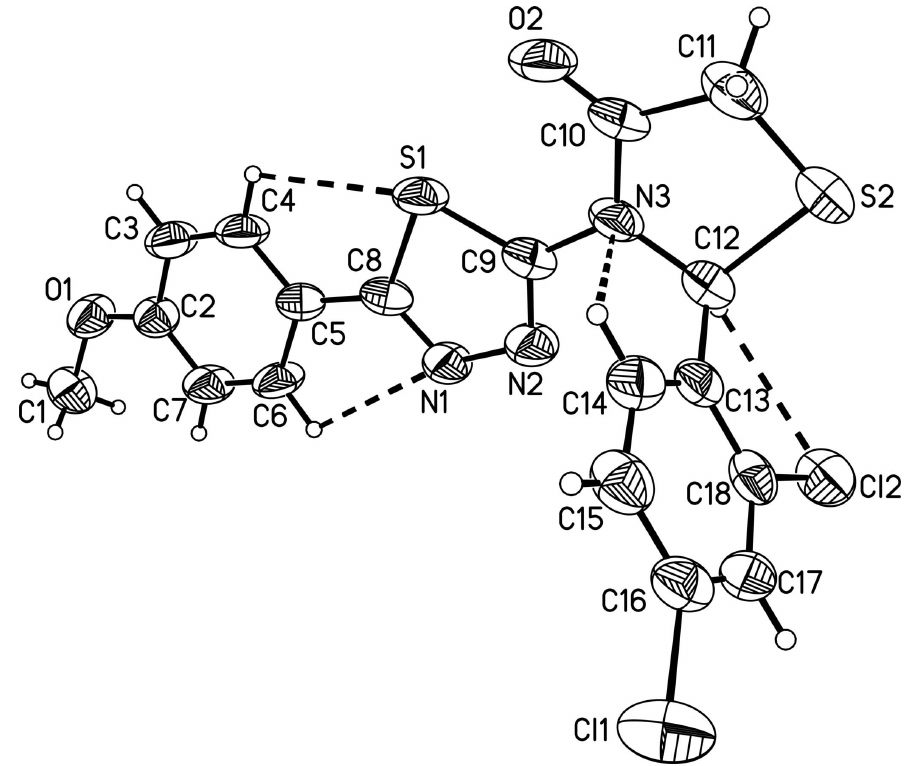
Figure 1 The molecular structure of the title molecule, with the atom-numbering scheme. Displacement ellipsoids are drawn at the 50% probability level. Hydrogen bonds are shown as dashed lines